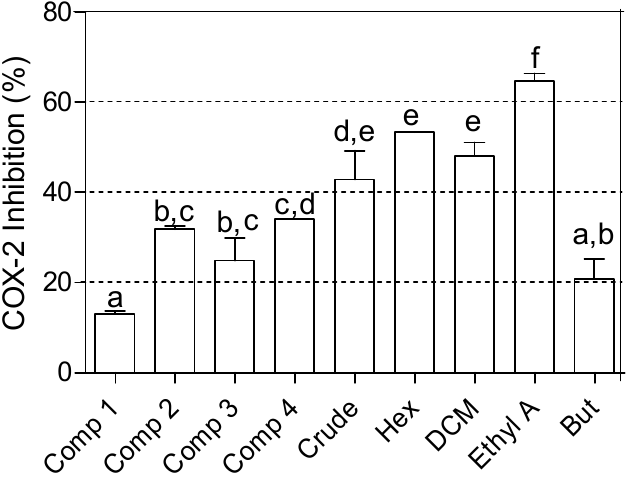
Figure 2. The percentage inhibition of COX-2 by the isolated compounds, crude extract and fractions of Croton menyharthii . Comp (at concentrations of 25 µg/mL) 1 ,